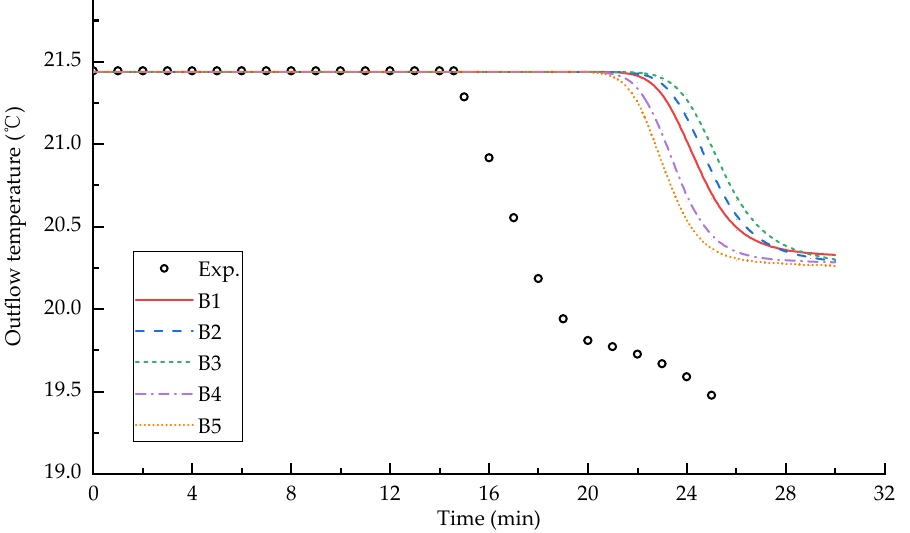
Figure 6. Time variation of outlet water temperature for the z-coordinate system model with different grid resolutions.